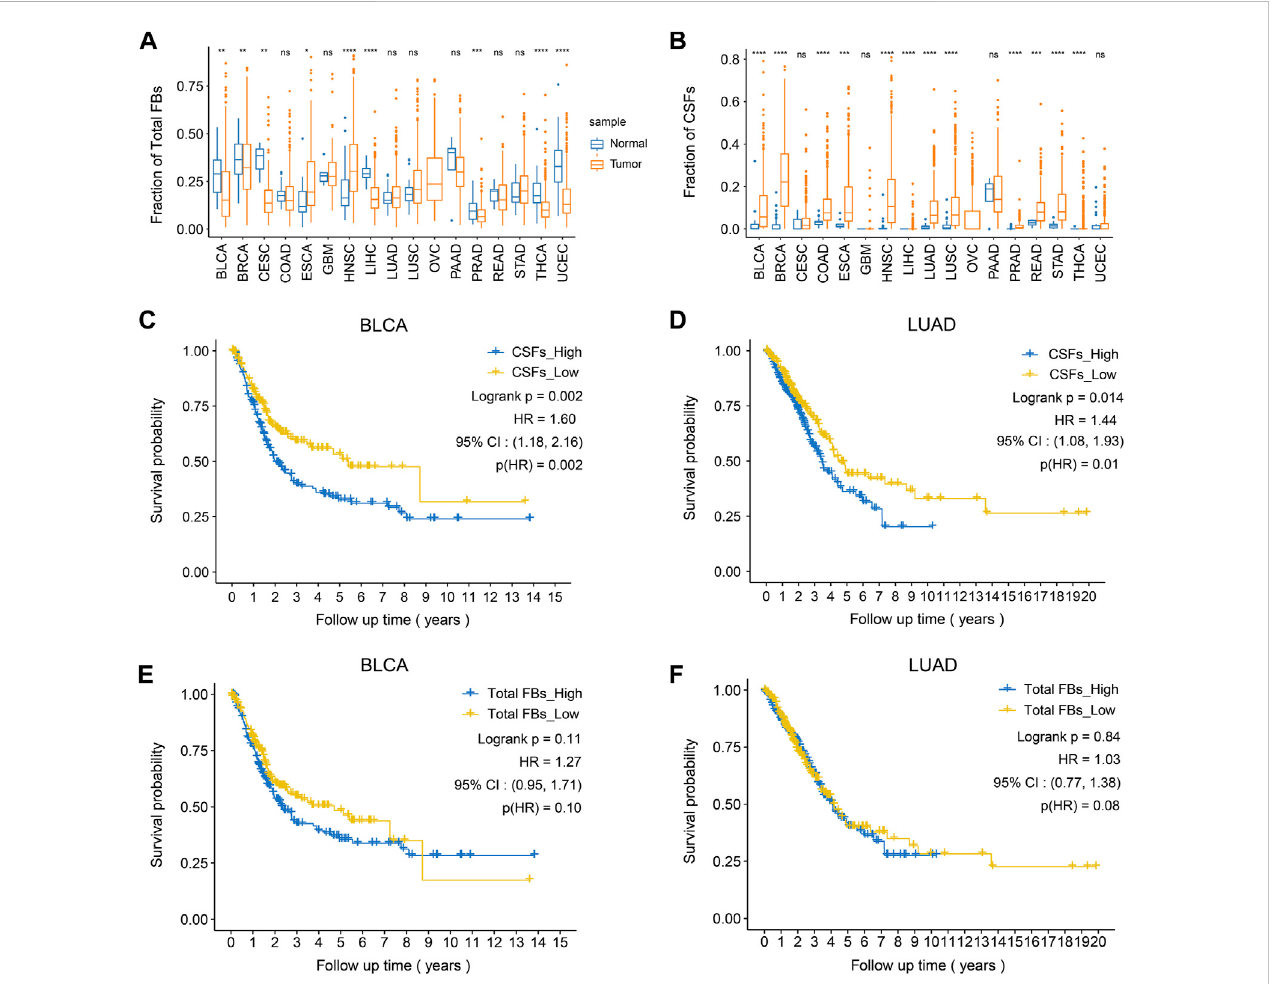
FIGURE 5 HighCSFsproportionisassociatedwithpoorprognosisinbladdercancerandlungadenocarcinoma. (A) ,Thefractionsoftotal fi broblastsintumortissues and normal tissues in 17 TCGA cancer types. (B) , The fractions of CSFs in tumor tissues and normal tissues in 17 TCGA cancer types. (C, D) , Kaplan-Meier plots to depict the survival of patients with high CSFs or low CSFs in BLCA (C) and LUAD (D) . (E, F) , Kaplan-Meier plots to depict the survival of patients with high or low fi broblasts in BLCA (E) and LUAD (F) . HR, hazard